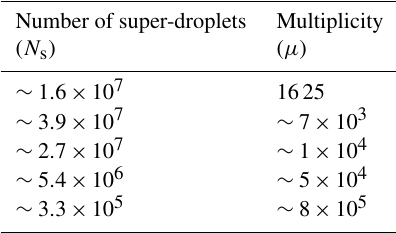
Table 3. Number of super-droplets and multiplicity for